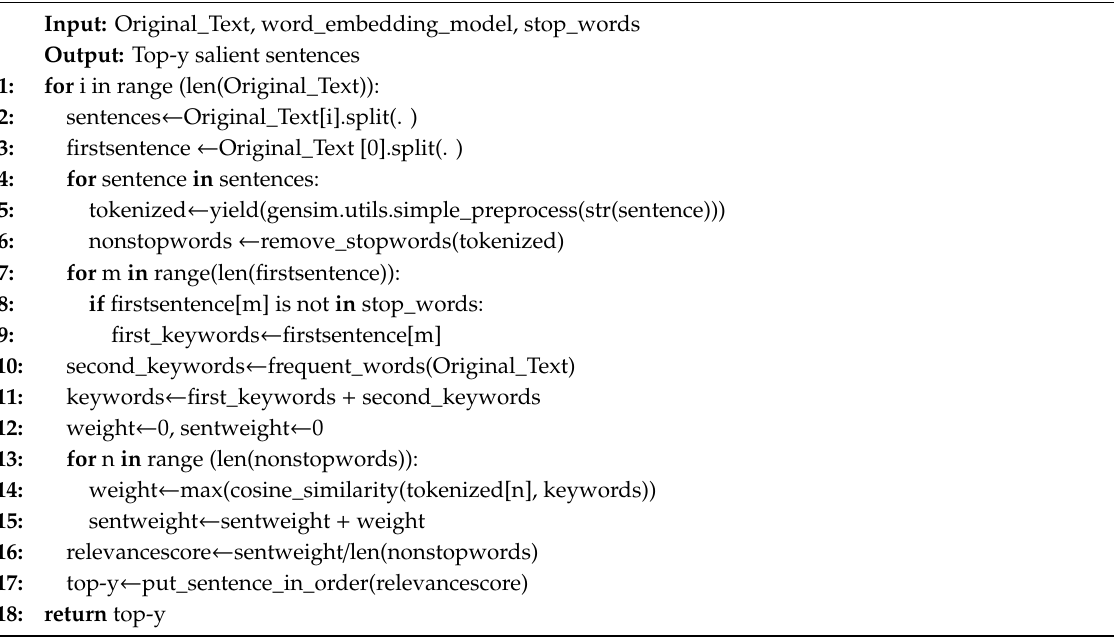
Algorithm 1: Word Embedding based Text